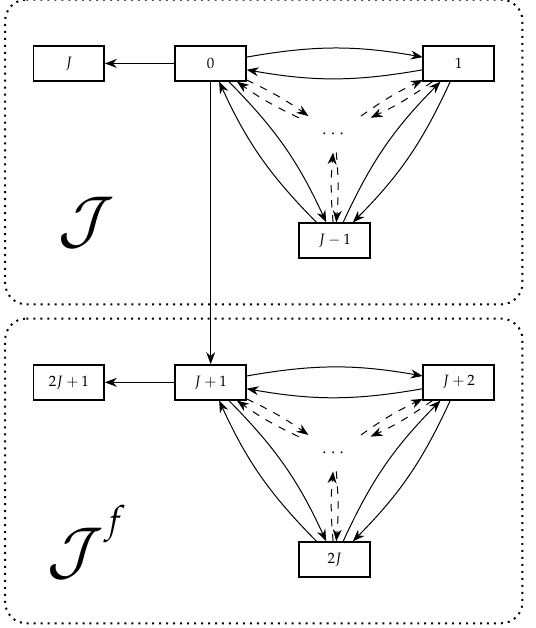
Figure 1. Multi-state model including policyholder behavior options.